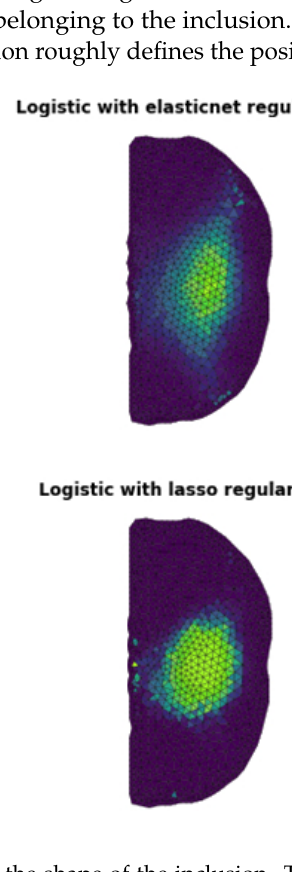
Figure 7. The top left panel shows the shape of the inclusion. The other panels show the results obtained by logistic regression with regularization methods as shown in the